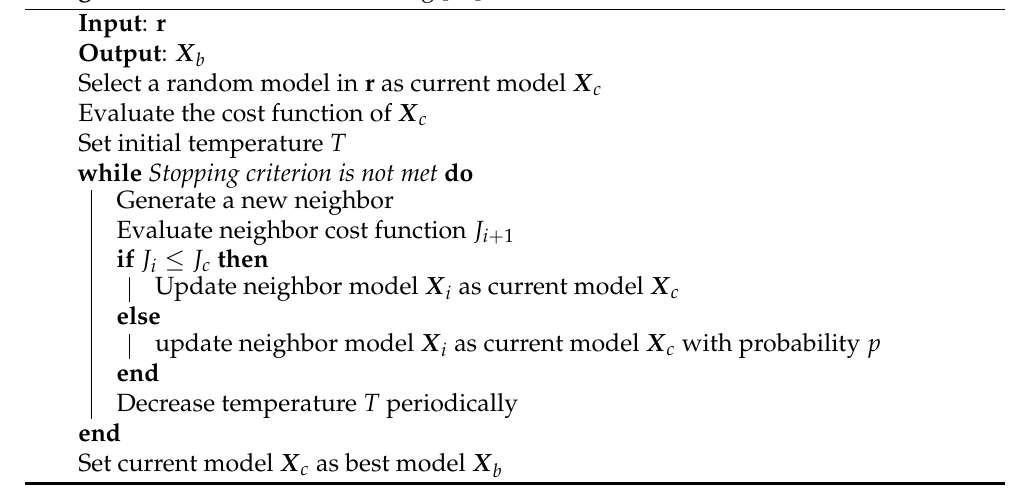
Algorithm 9: Simulated Annealing